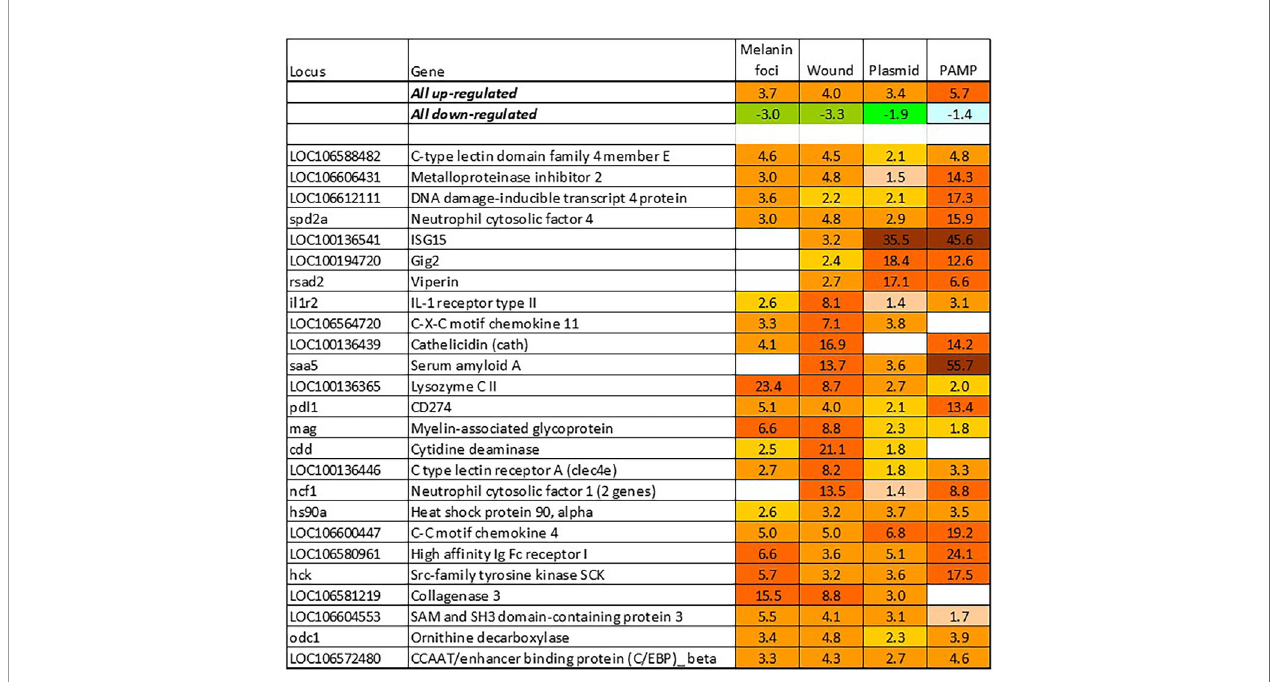
FIGURE 5 | Responses to in fl ammation not caused by pathogenic bacteria. Genes are ranked by the expression changes. Information on tissues, cells and time- points is in Table 1